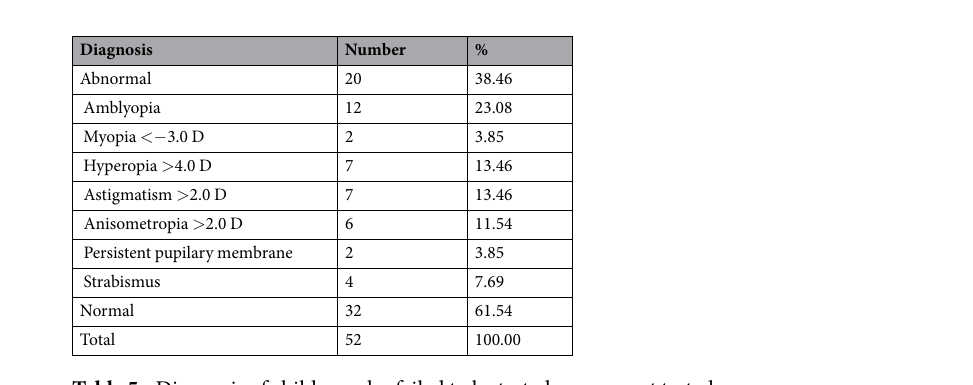
Table 5. Diagnosis of children who failed to be tested or were not